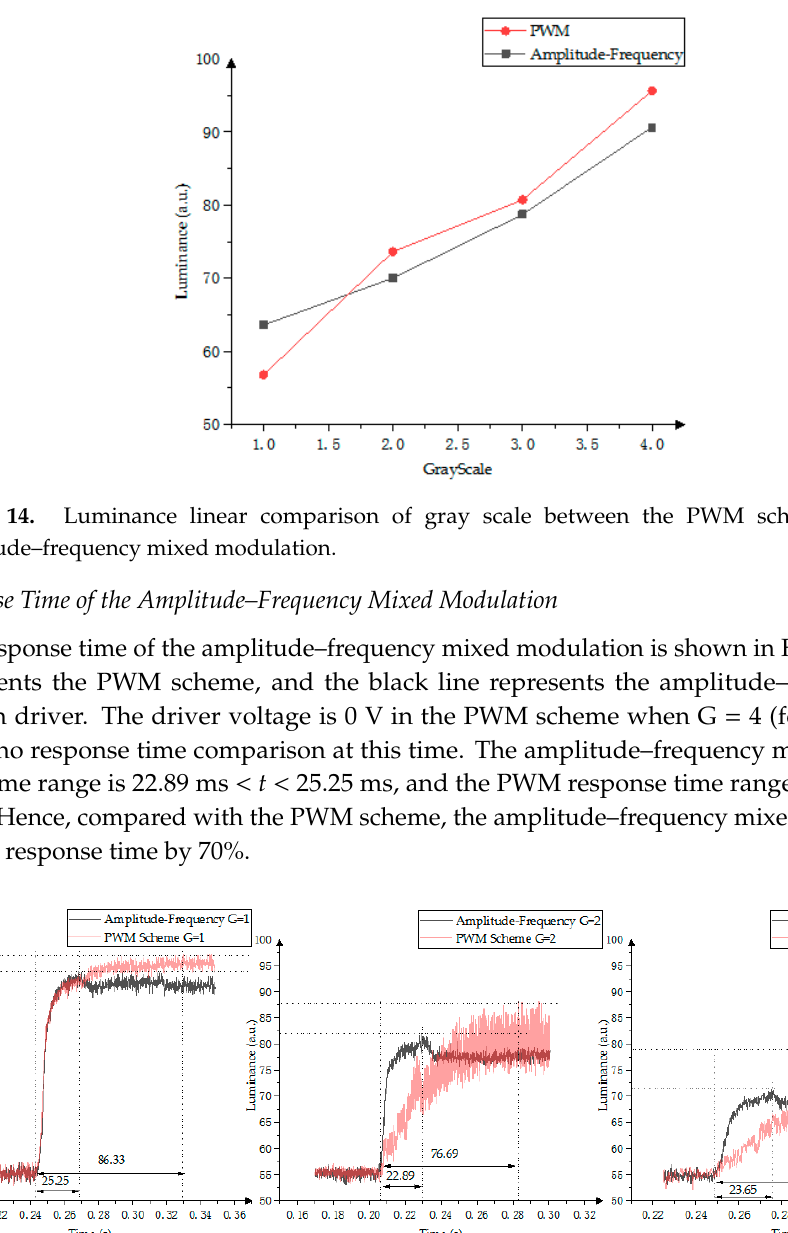
Figure 13. Stable image of pixel when the gray scale is 3. ( a ) PWM scheme; ( b ) Amplitude–frequency mixed modulation.